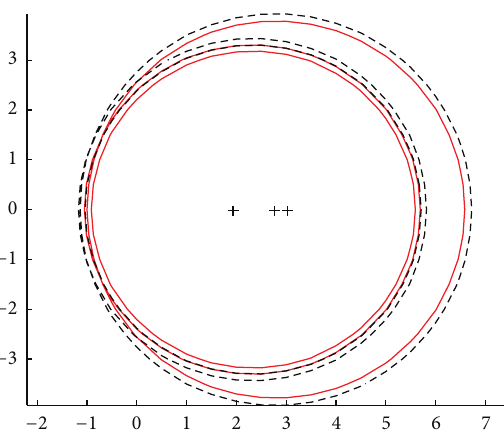
Figure 3: The red dotted line and black dashed line denote the corresponding discs Γ 3 and Γ 󸀠 3 ,